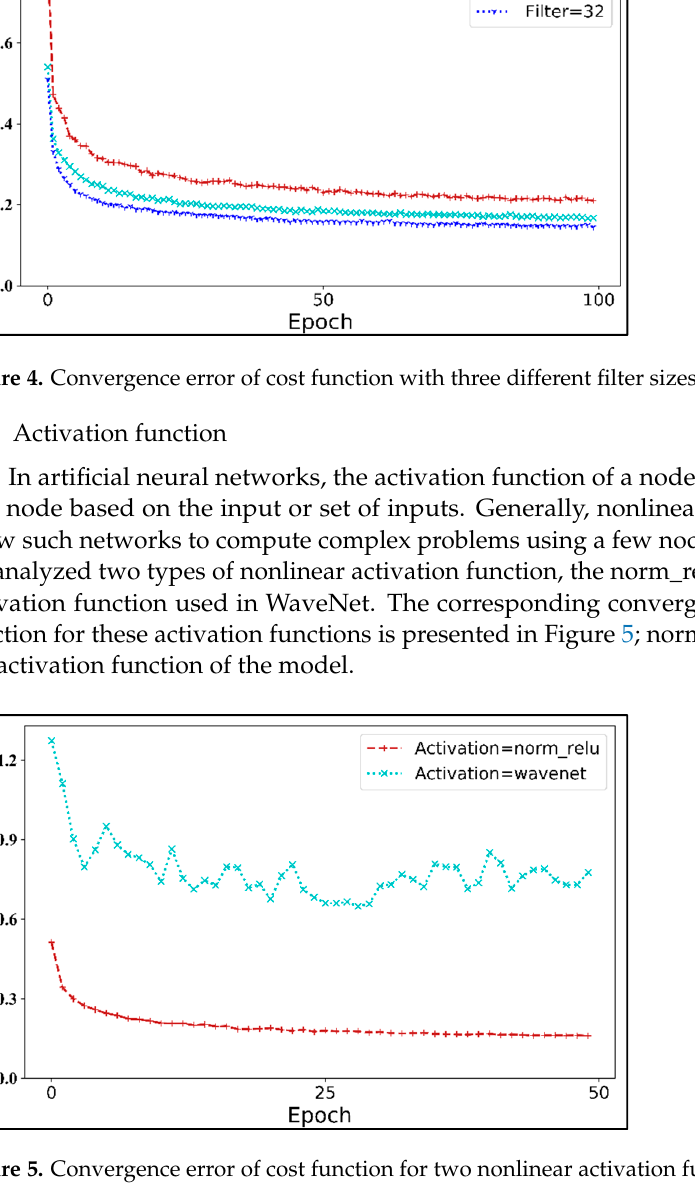
Figure 3. Detailed diagram of the dilated residual block.